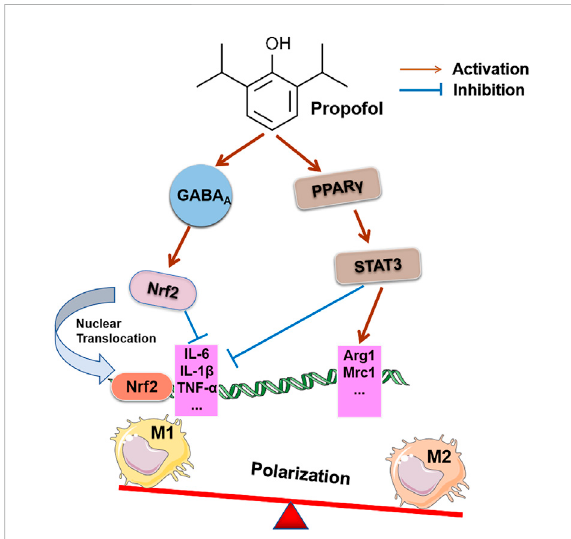
FIGURE 3 Effects of propofol on macrophage polarization. Invasive surgery may cause M1 macrophage polarization and related complications. Propofol inhibits the expression of IL-6 and IL-1 β by activating the GABAA receptor to induce Nrf2 accumulation in the cytoplasm and its translocation into the nucleus, which prevents the in fl ammatory response during the polarization of human macrophages. Propofol treatment stimulated PPAR γ activation in the rI/R model and enhanced PPAR γ -mediated STAT3, decreased iNO S mRNA of the M1 target gene, increased Mrc1 and Arg1 mRNA expression of the M2 target gene, and promoted M2 polarization in